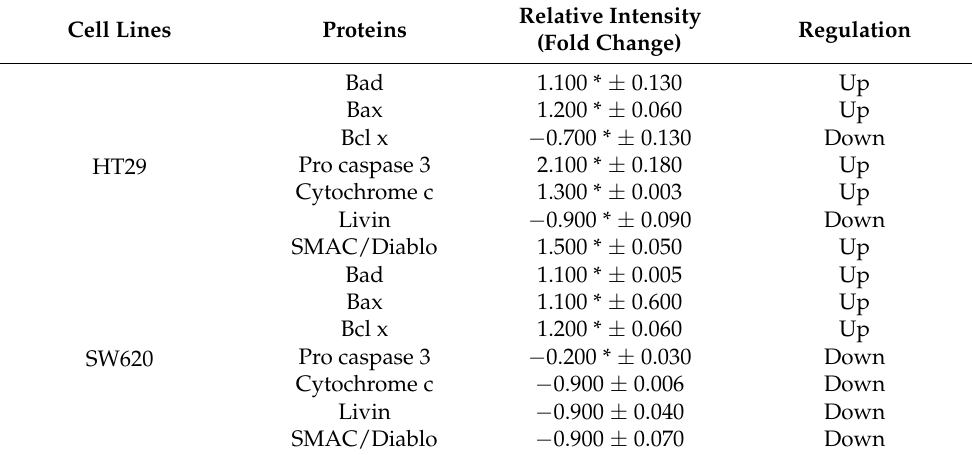
Figure 8. The proteome profiler membranes depicting expression of the regulated proteins between control and DMCH- treated HT29 and SW620. Table 2. Apoptosis pathway-related protein expression in DMCH-treated HT29 and